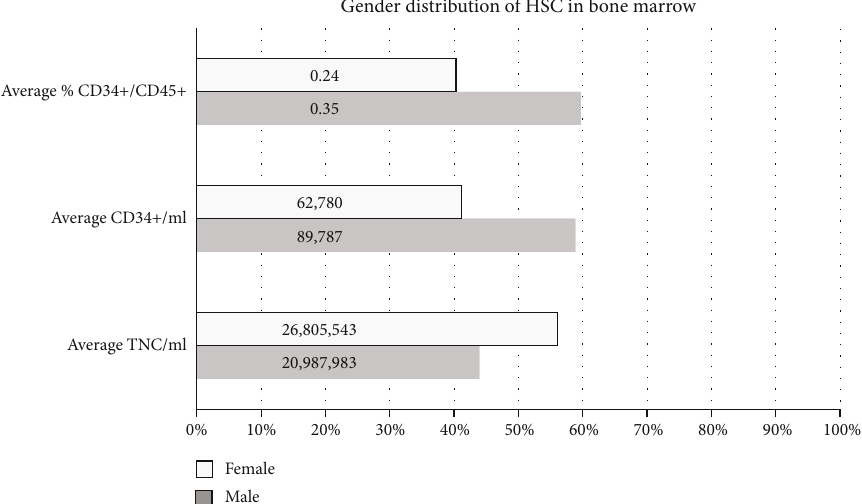
Figure 1: Distribution of hematopoietic stem cells (HSC) (CD34+/CD45+) in deceased donor iliac crest bone marrow based on gender ( n = 7